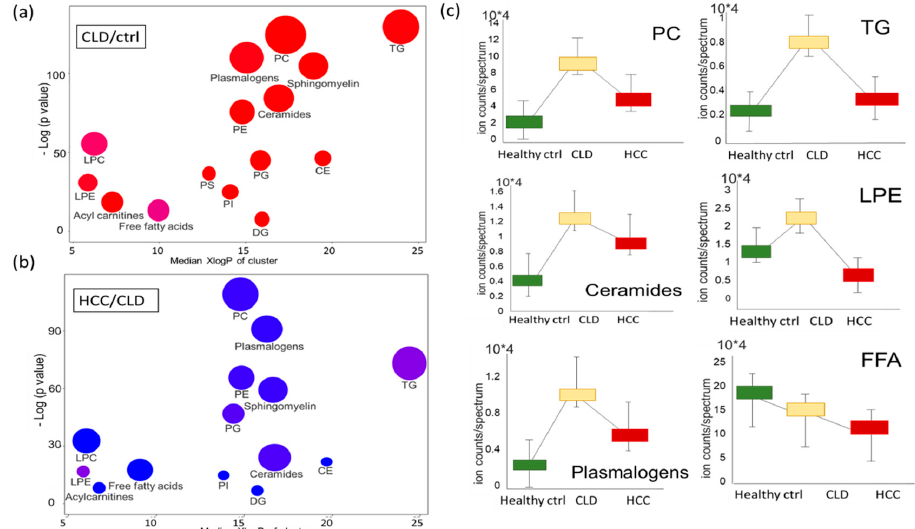
Figure 4. Dysregulated blood lipid metabolism of healthy control subjects and chronic liver disease (CLD) and HCC patients. ( a ) Chemical set enrichment statistics (ChemRICH) comparing CLD patients to healthy control subjects. ( b ) ChemRICH plot comparing HCC to CLD patients. Bubble colors range from red (increased) to blue (decreased), with purple colors indicating both increased and decreased lipid species in lipid classes. Bubble size represents the number of compounds per lipid class. ( c ) Box plots of average blood lipid intensities (normalized peak heights) with standard deviations, indicating differences between healthy controls and CLD and HCC groups. Abbreviations: PC, phosphatidylcholines; PE, phosphatidylethanolamines; PG, phosphatidylglycerols; PS, phosphatidylserines; PI, phosphatidylinositols; CE, cholesteryl esters; LPC, lysophosphatidylcholines; LPE, lysophoaphatidylethanolamines; LPC, lysophosphatidylcholines; FFA, free fatty acids; DG, diacylglycerols; TG, triacylglycerols.